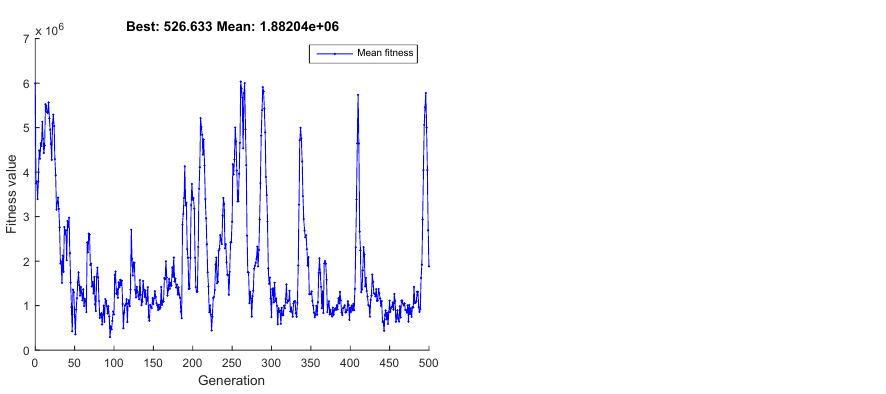
Figure 31. Suitability average in the optimization of variables pos , pot , and qtd with bar constraints. The initial evaluation function is f ( (cid:126) x ) = 1046.20 and the value of the final evaluation function was f ( (cid:126) x ∗ ) = 526.63, promoting an improvement of ≈ 50% in the evaluation